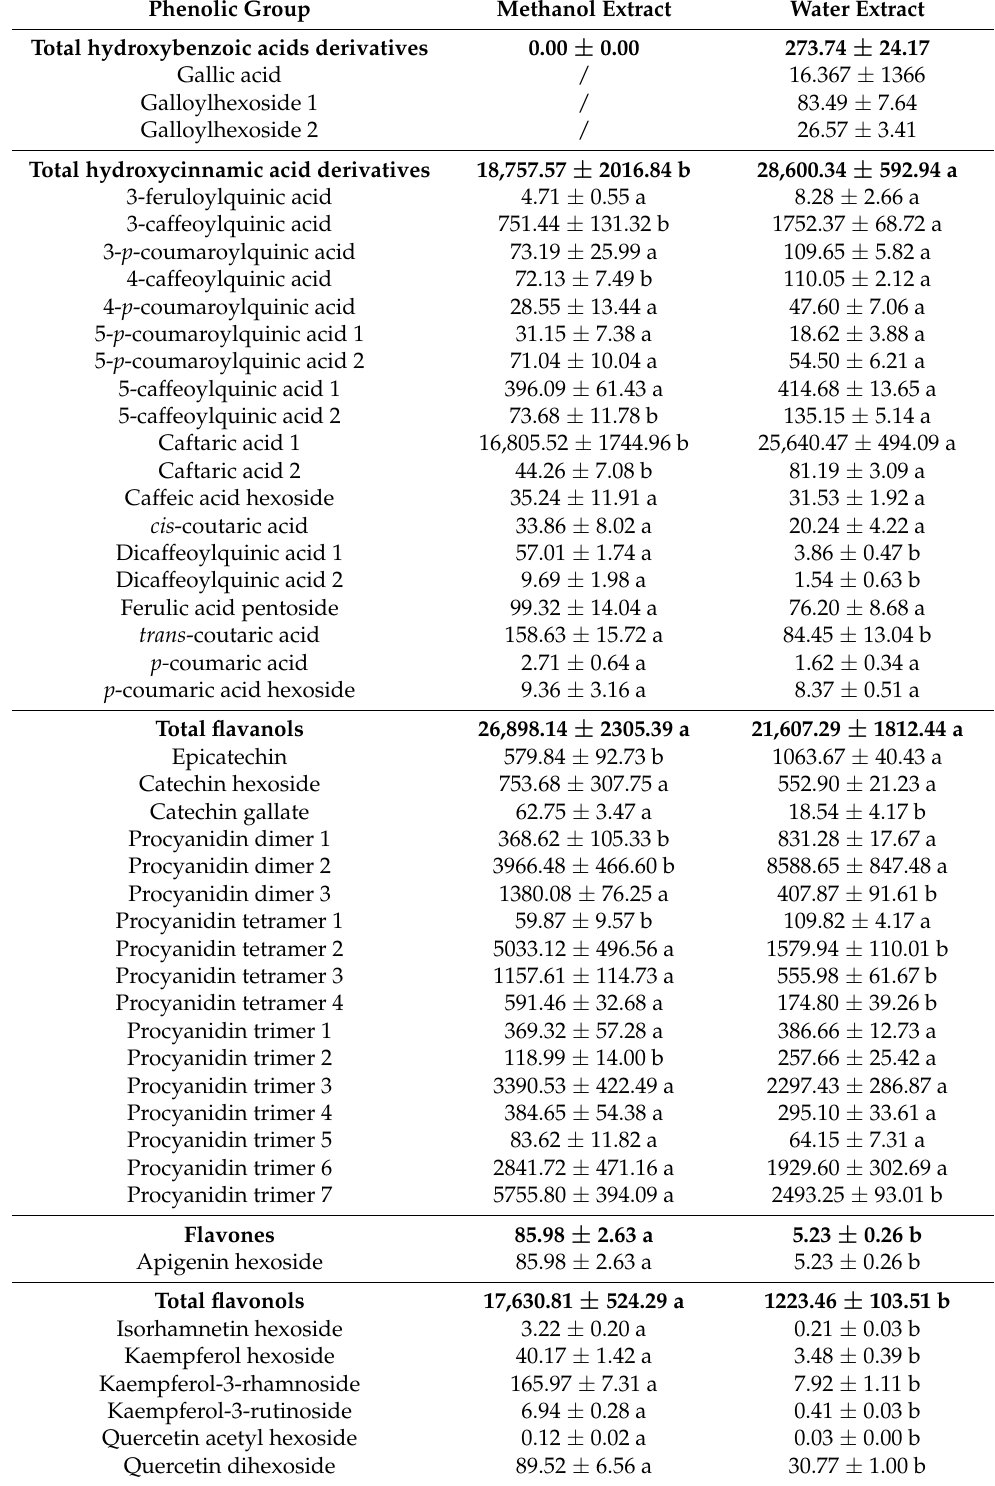
Table 1. Contents of individual analyzed secondary metabolites with standard error ( µ g/g DW) in Japanese knotweed with two extraction